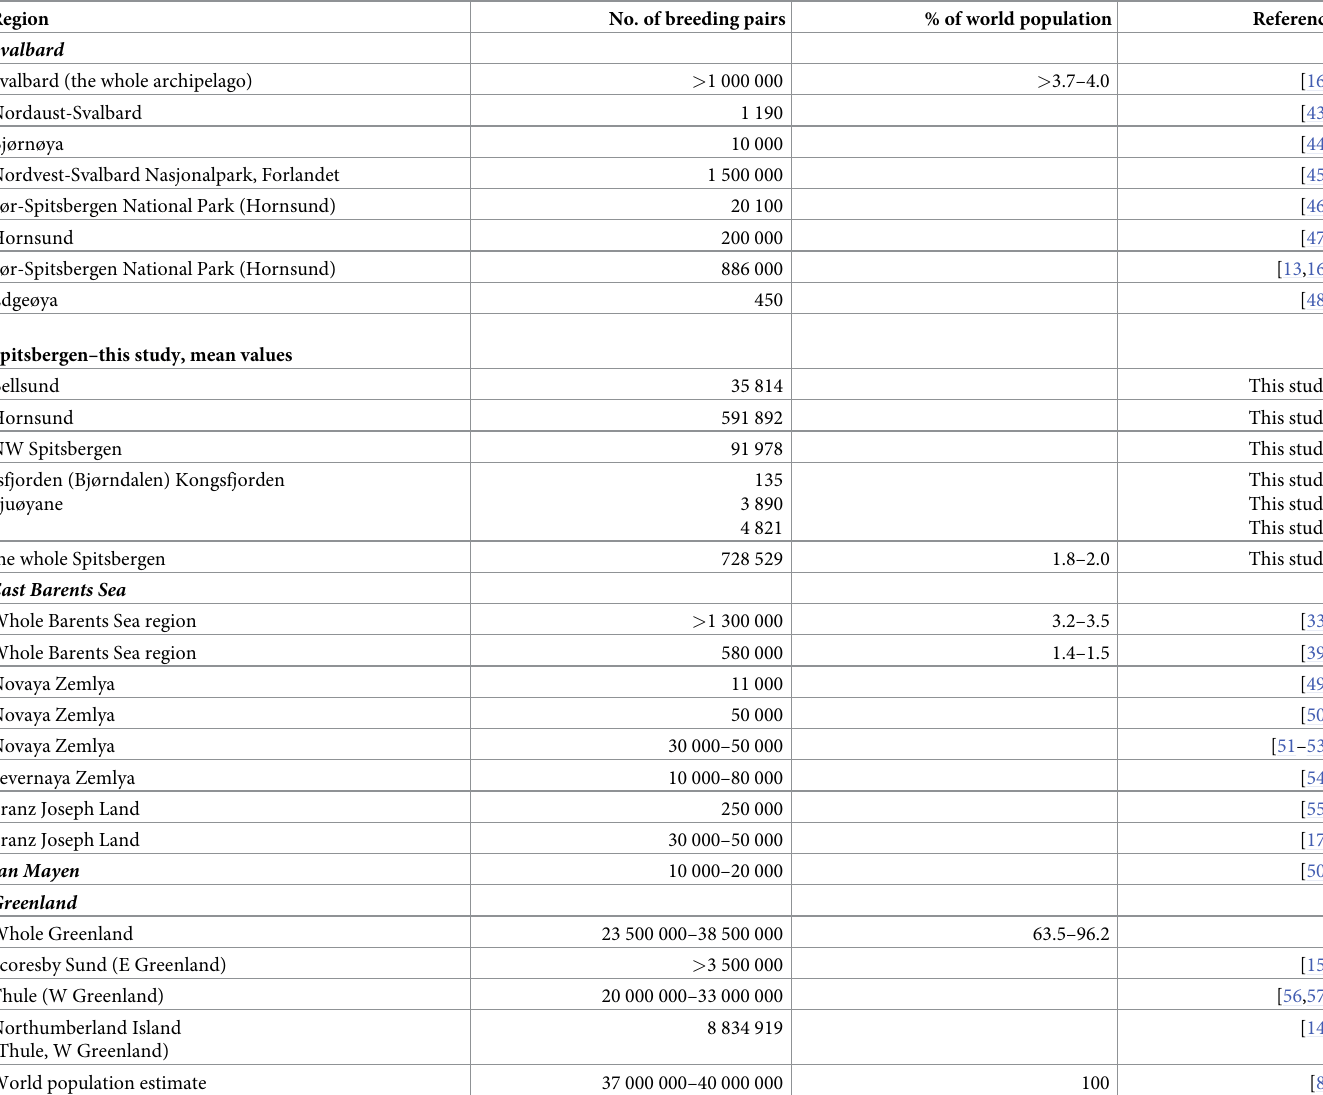
Table 5. Breeding population estimates for the little auks according to available literature and this study